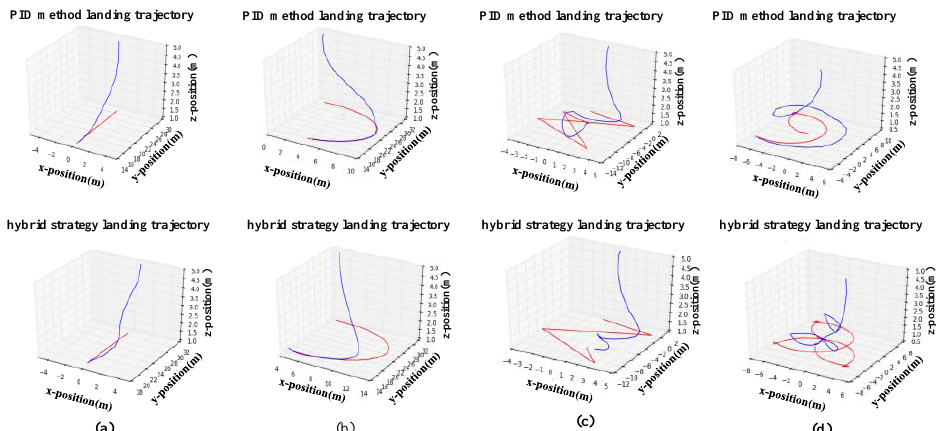
Figure 9. Trajectory of UAV while landing on a moving platform for ( a ) linear motion, ( b ) circular motion, ( c ) random motion, and ( d ) random motion.